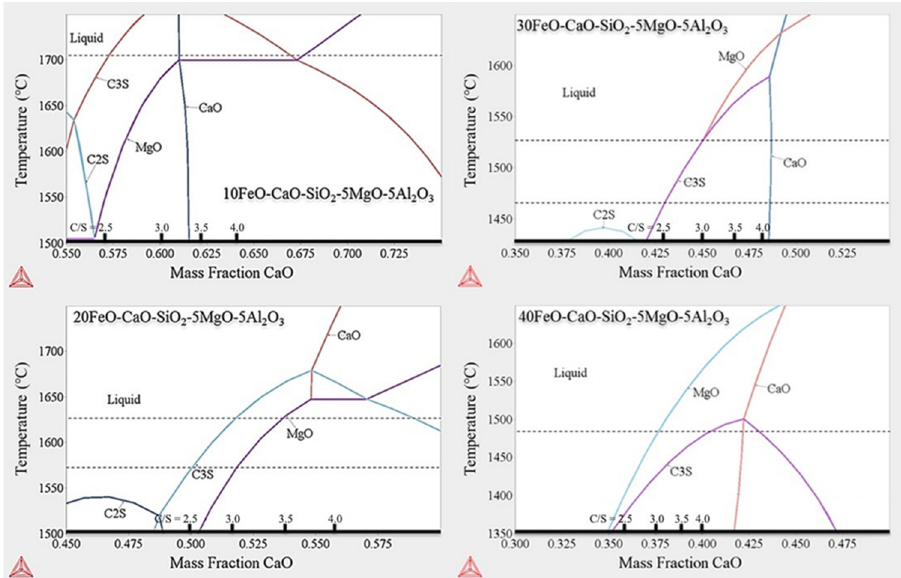
Figure 4. Results obtained with Thermo-Calc software package.